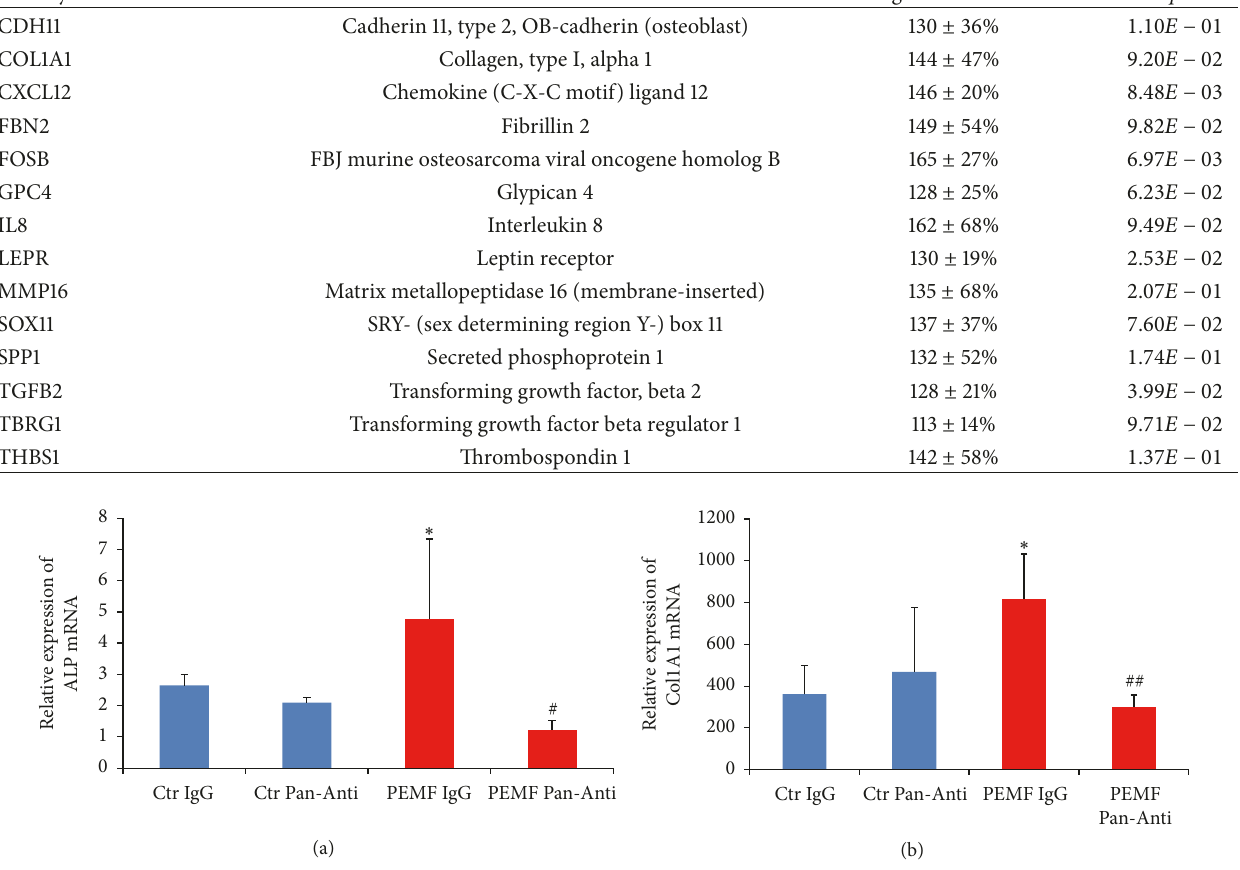
Figure 5: PEMF resulted in stimulation of expression of osteoblast differentiation marker genes via the TGF- 𝛽 signaling pathway. Differentiated human osteoblasts derived from hBMSCs from a 30-year-old female were used. Total RNA was isolated after incubation with IgG or pan-TGF- 𝛽 antibody (Pan-Anti) and treatment with control (Ctr) or PEMF and subjected to RT-qPCR using the primers for (a) ALP and (b) collagen 1A1 genes. RPL13 was used to normalize gene expression. 𝑛 = 3 . ∗ indicates significant increase compared with control IgG. # indicates significant decrease compared to all groups with ALP mRNA expression; ## indicates significant decrease compared to control or PEMF treatment with IgG incubation with collagen 1A1 mRNA expression; analysis by one-way